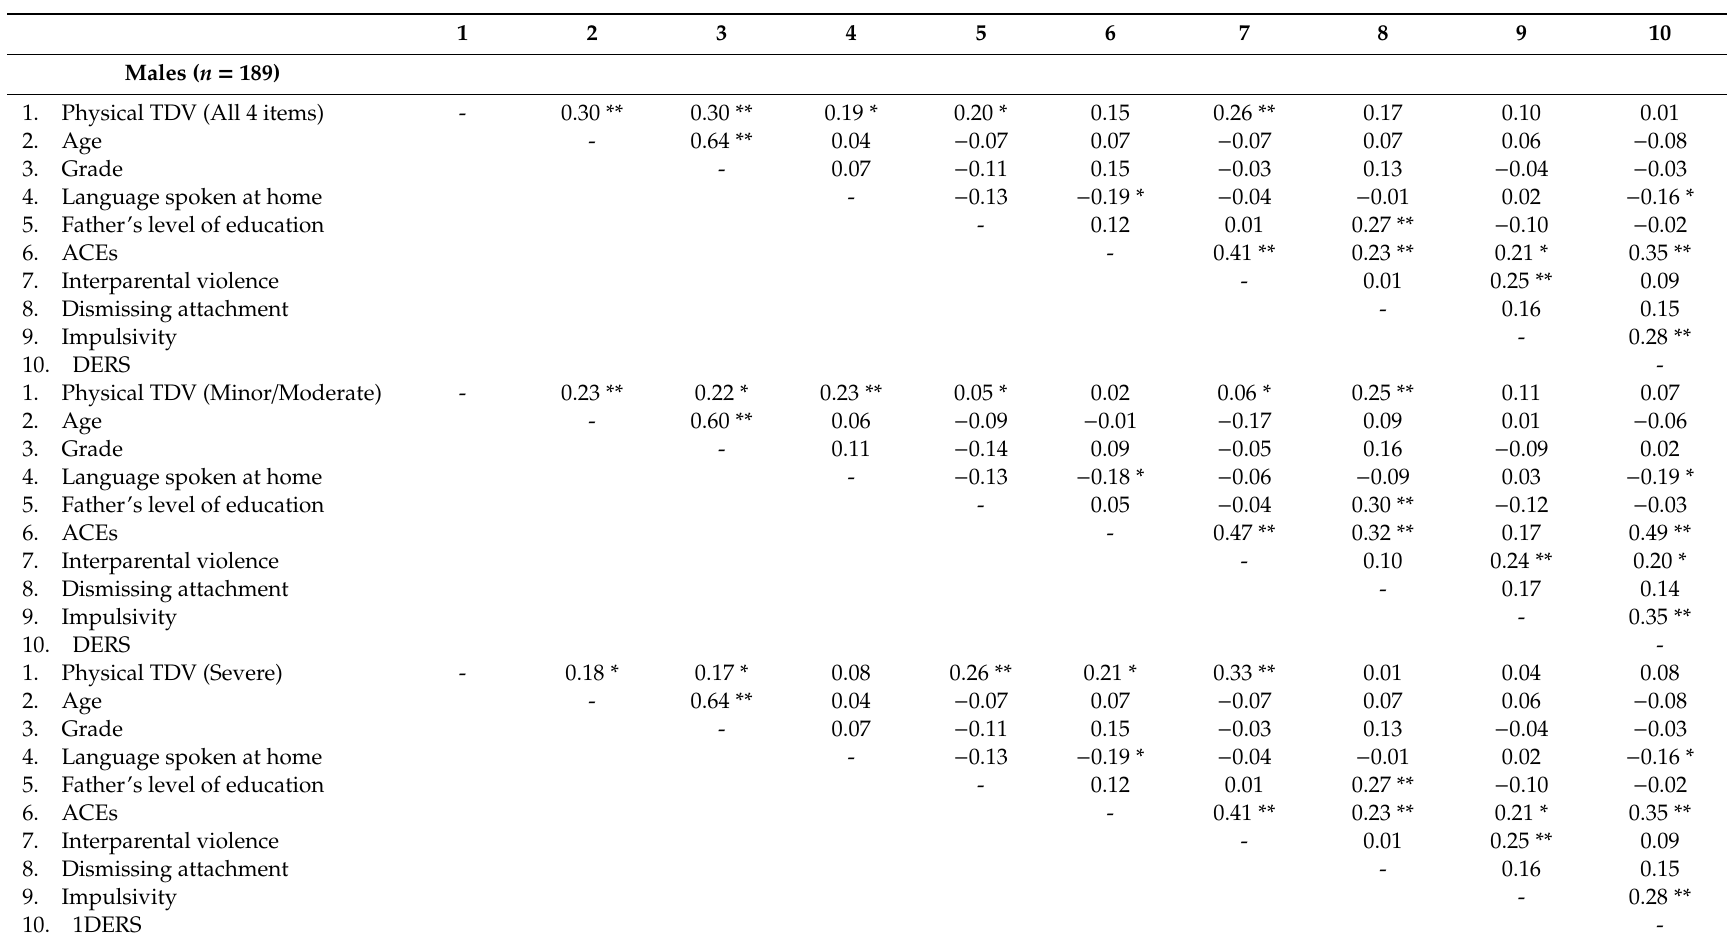
Table 4. Bivariate correlations among study variables for